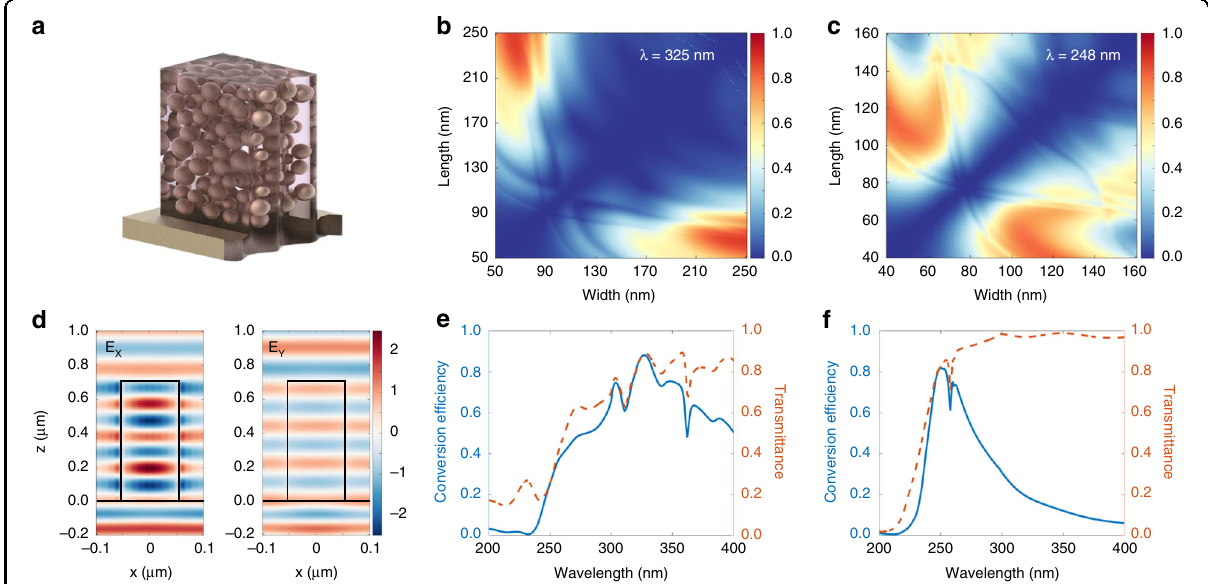
Fig. 2 Design and simulation of the high-ef fi ciency meta-atom operating in near-UV and deep-UV. a Schematic illustration of the printable meta-atom consisting of ZrO 2 nano-PER. b Simulated conversion ef fi ciencies for meta-atoms at λ = 325 nm. Width and length parameters are varied from 50 nm to 250 nm with fi xed height (700 nm) and period (300 nm). c Simulated conversion ef fi ciencies for meta-atoms at λ = 248 nm. Width and length parameters are varied from 40 nm to 160 nm with fi xed height (700 nm) and period (200 nm). d Simulated electric fi eld pro fi les at λ = 248 nm. Real part of the x component (left) and y component (right) of the electric fi eld. Simulated conversion ef fi ciency and transmittance of designed meta- atom operating in e λ = 325 nm and f λ = 248